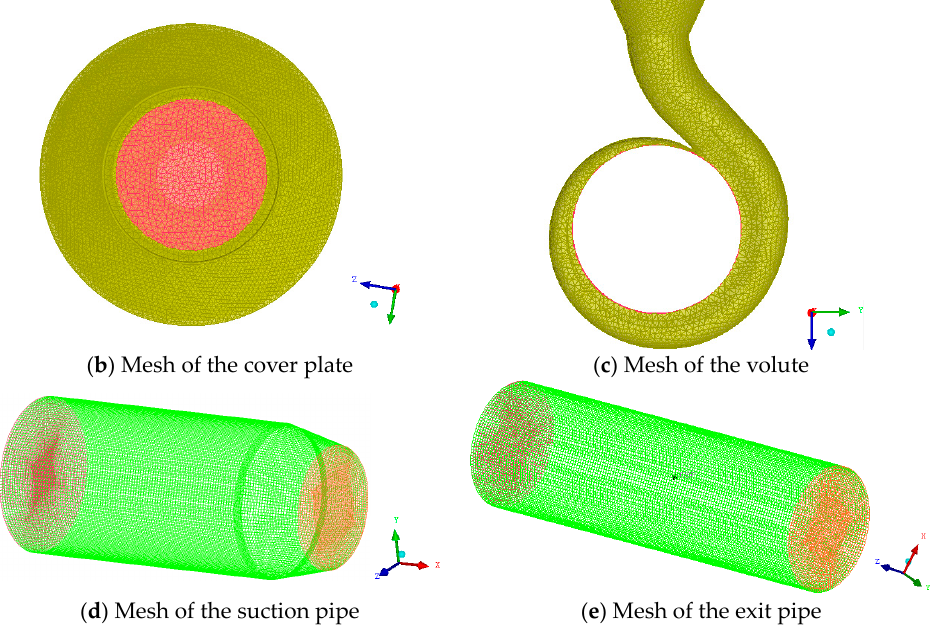
Figure 8. Meshes of the computational domain of the centrifugal pump.